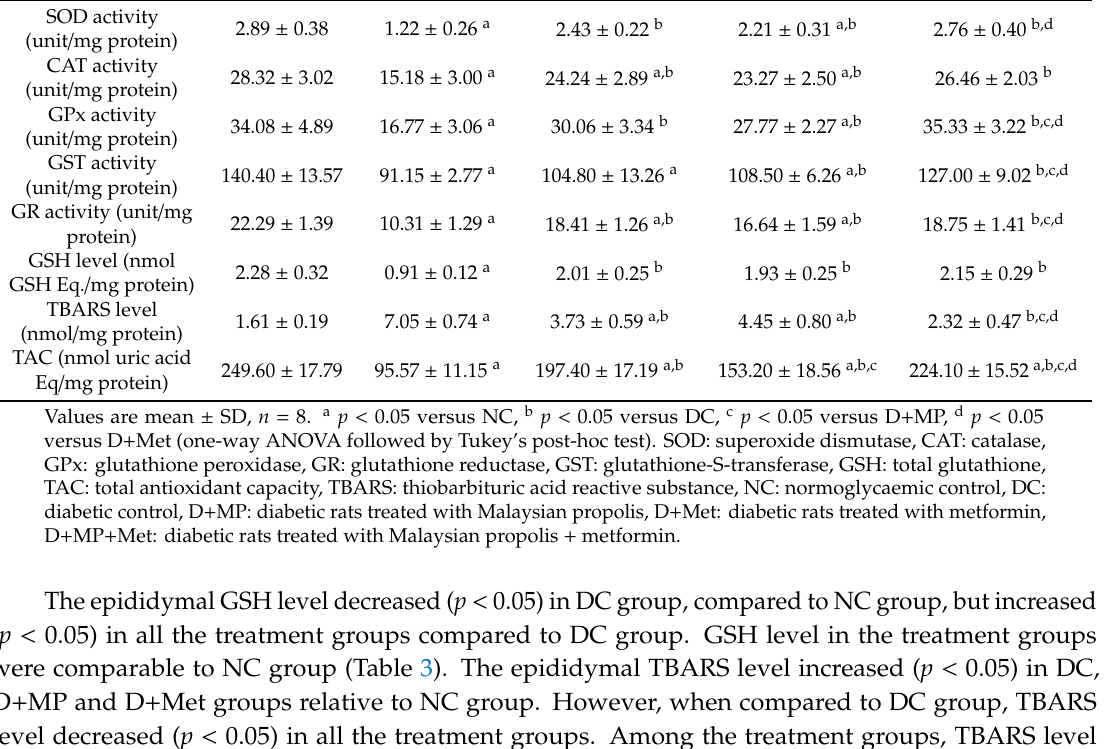
Table 3. Epididymal antioxidants, TBARS level and total antioxidant capacity.